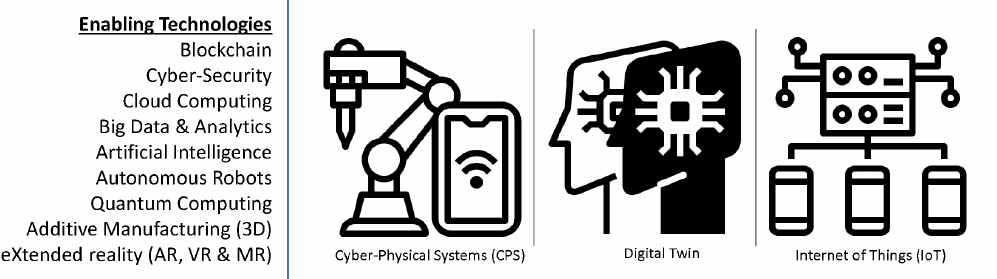
Figure 2. Emerging technologies enabling the development of the Future